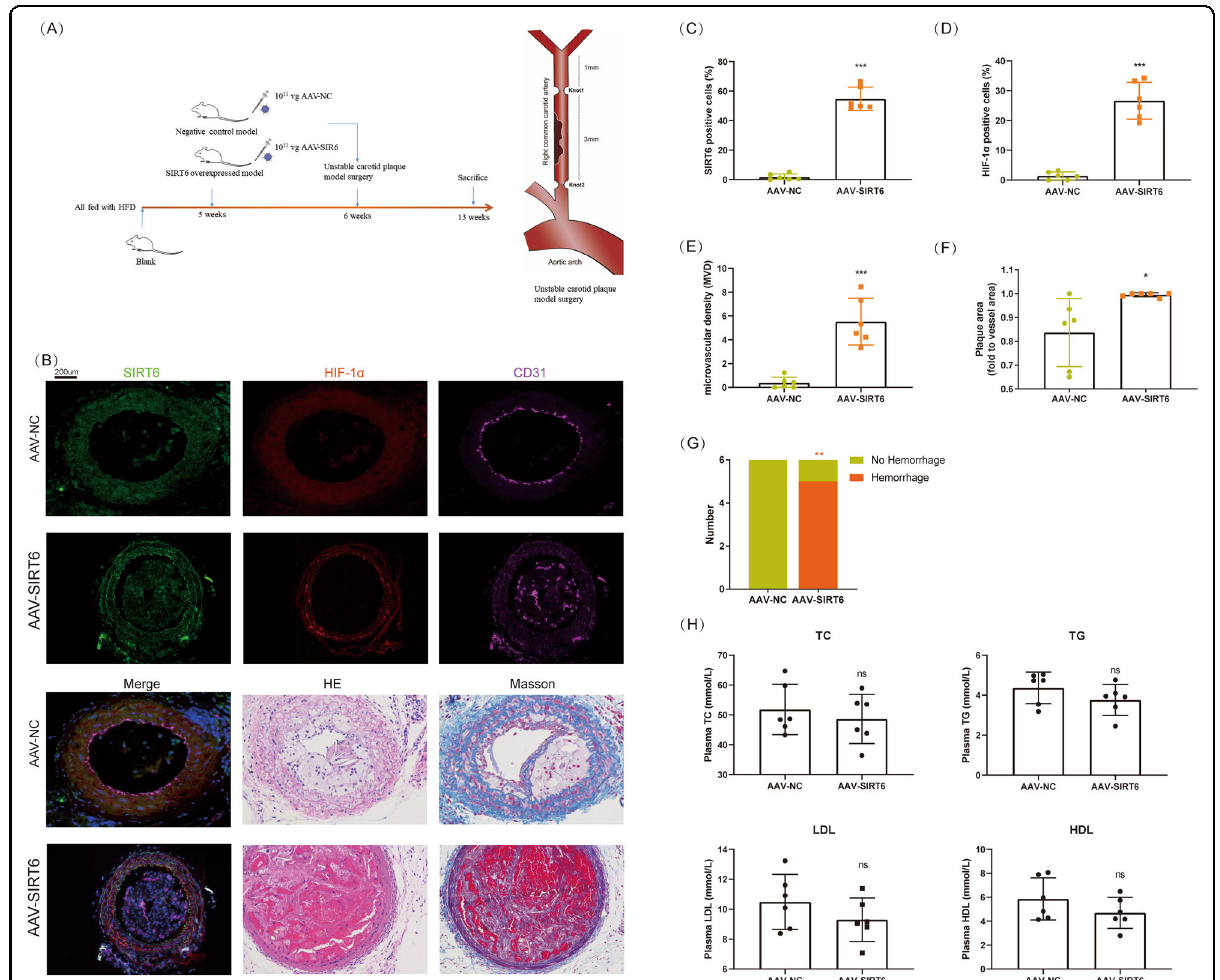
Fig. 2 Overexpression of SIRT6 promoted angiogenesis and hemorrhage in carotid plaque. A Establishment of a mice model with unstable carotid plaque. SIRT6 was overexpressed by adenovirus associated virus ( n = 6). B Immuno fl uorescence of SIRT6, HIF-1 α , and CD31; HE staining; Masson staining of carotid plaque in mice model. C Analysis of the expression of SIRT6 in carotid plaque. D Analysis of the expression of HIF-1 α in carotid plaque. E Microvascular density (MVD, marked by CD31) in carotid plaque. F , G Plaque area and hemorrhage analyzed by HE staining and Masson staining. H Quanti fi cation of total cholesterol (TC), triglyceride (TG), low-density lipoprotein (LDL), and high-density lipoprotein (HDL) in serum of mouse model (ns: no signi fi cance, * P < 0.05, ** P < 0.01, *** P <